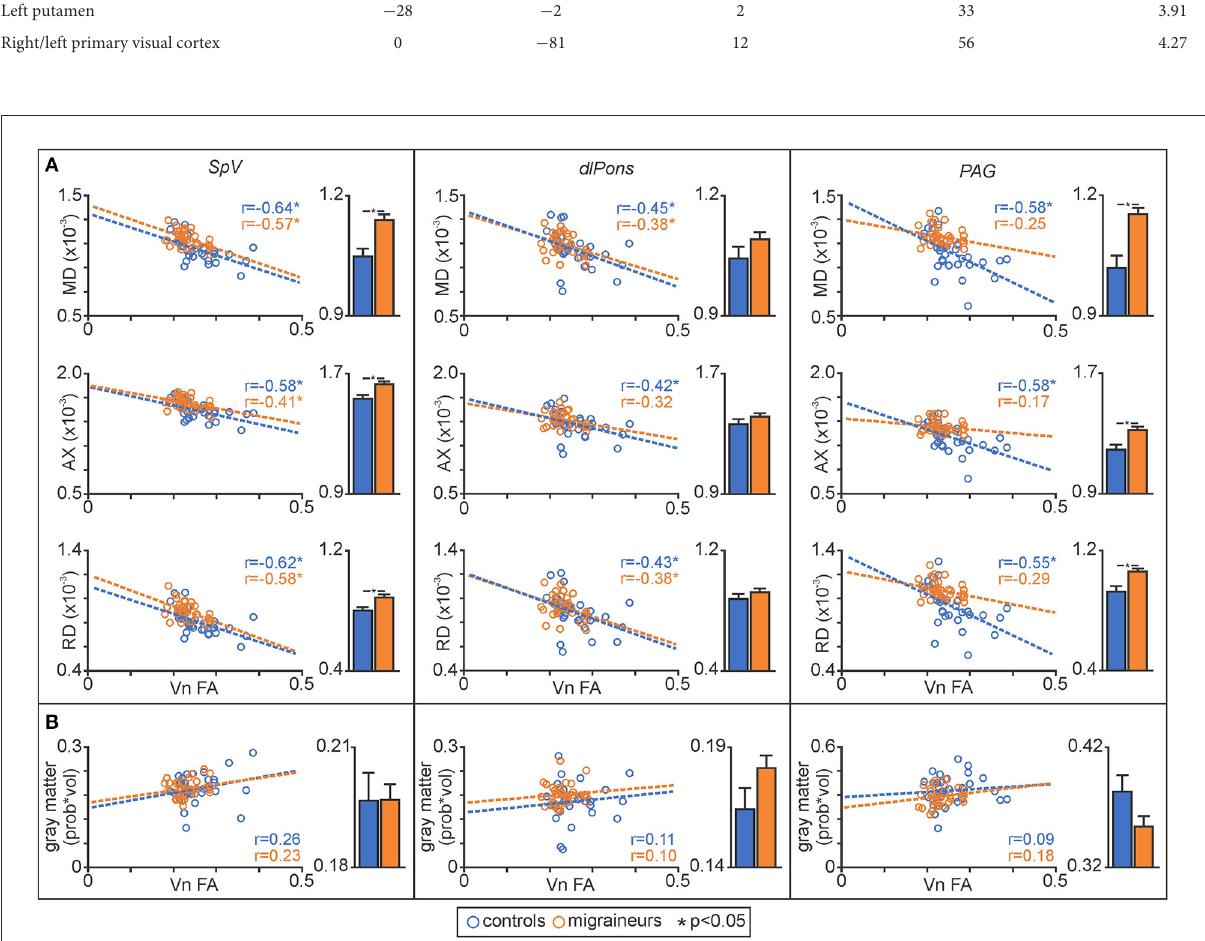
FIGURE3 (A) Plots of mean diffusivity (MD), axial diffusivity (AX) and radial diffusivity (RD) against trigeminal nerve fractional anisotropy (FA) for the spinal trigeminal nucleus (SpV), dorsolateral pons (dlPons) and the periaqueductal gray matter (PAG). In addition, to the right of each correlation plot are plots of mean ( ± SEM) MD, AX and RD values for each of the significant brainstem clusters. (B) Plots of gray matter volume against trigeminal nerve FA derived from significant MD clusters and plots of mean ( ± SEM) gray matter volume for each of the significant MD brainstem